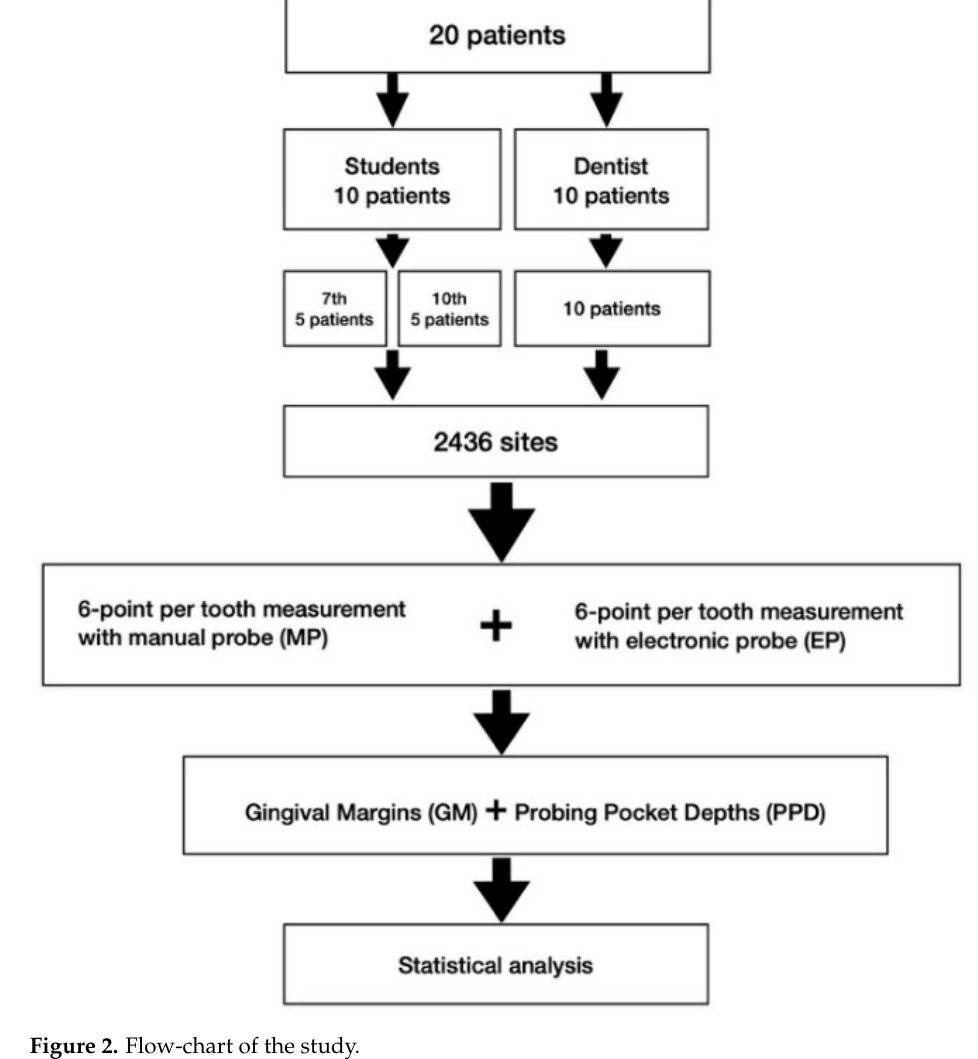
Figure 2. Flow-chart of the study.